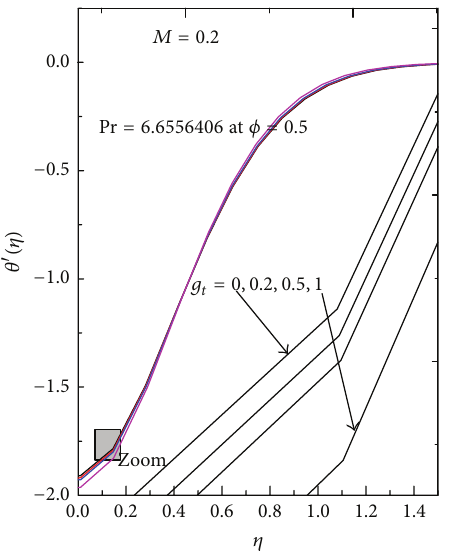
Figure8:Effectoftemperaturebuoyancyparameterontemperature gradient.